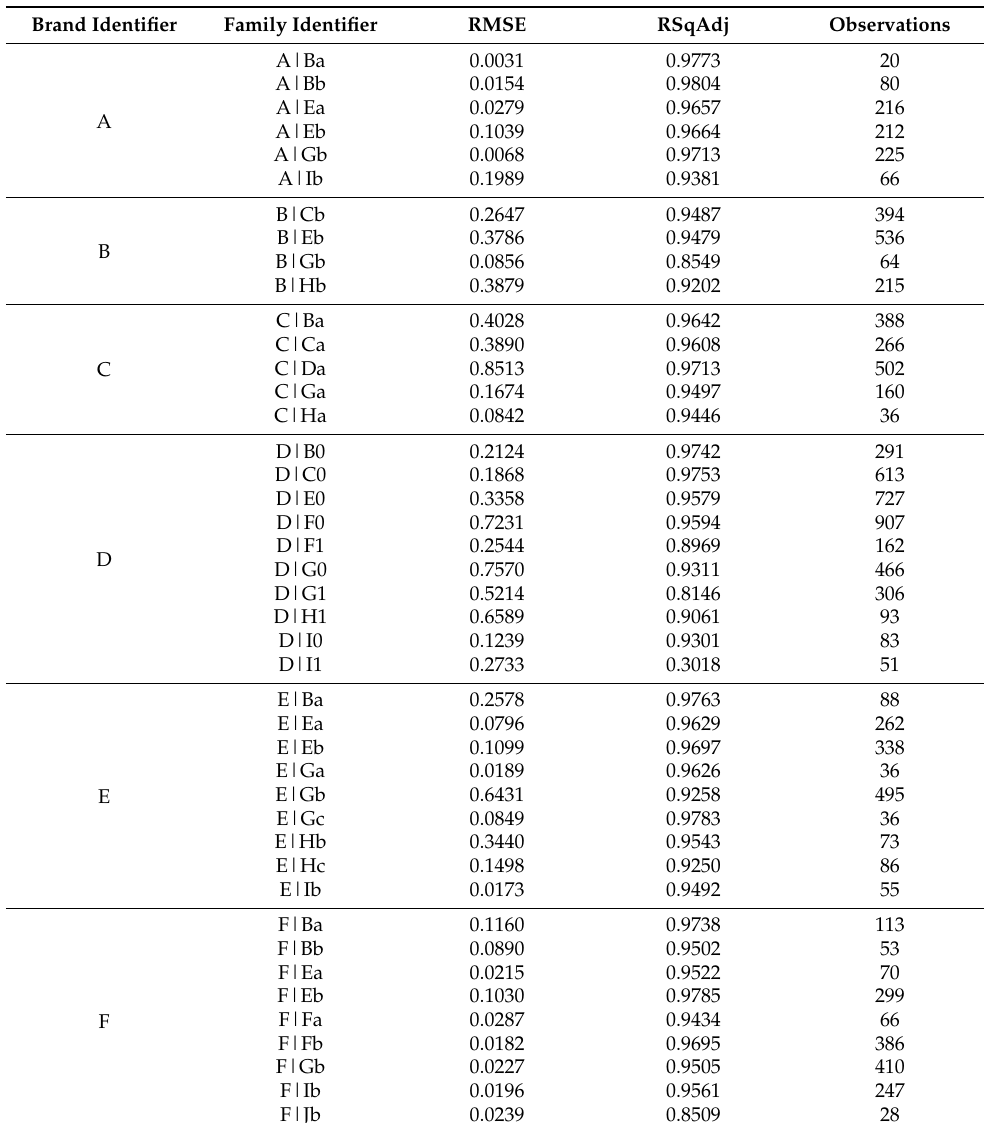
Table 8. Tractor family power regression